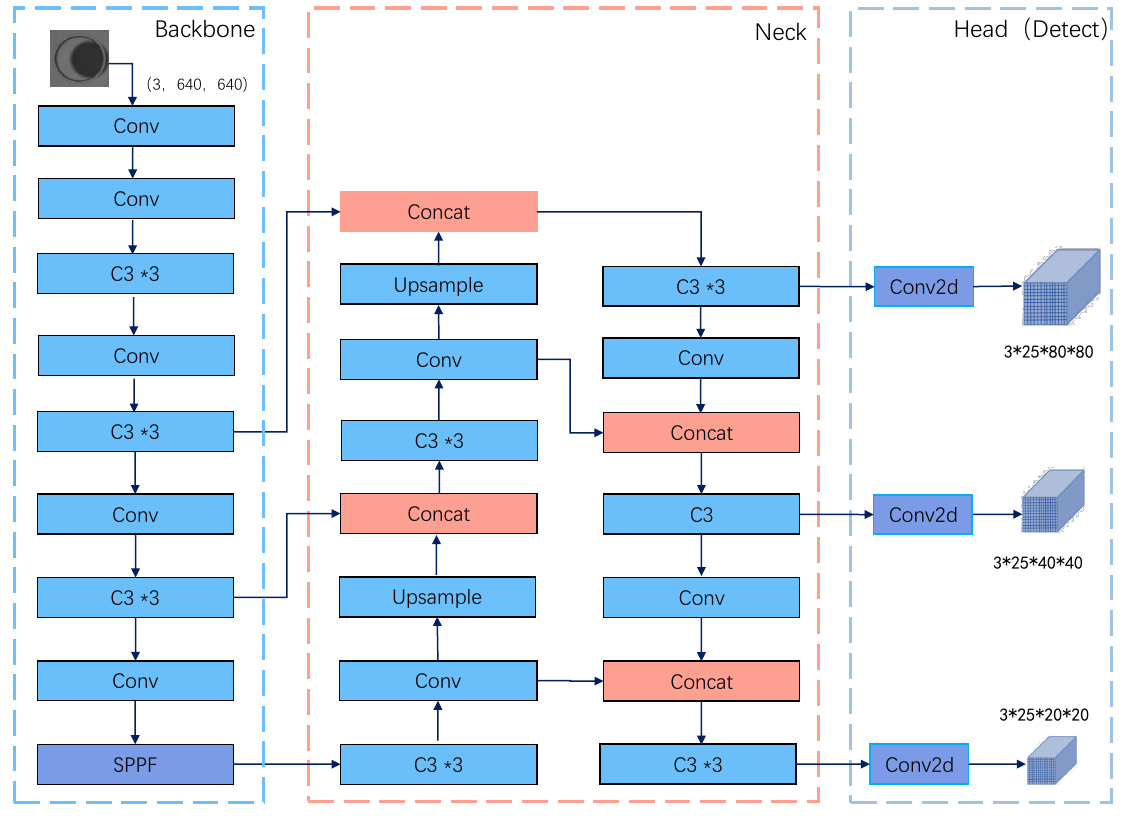
Figure 1. YOLOv5 network architecture. It mainly includes three parts: the backbone network, the neck, and the detection